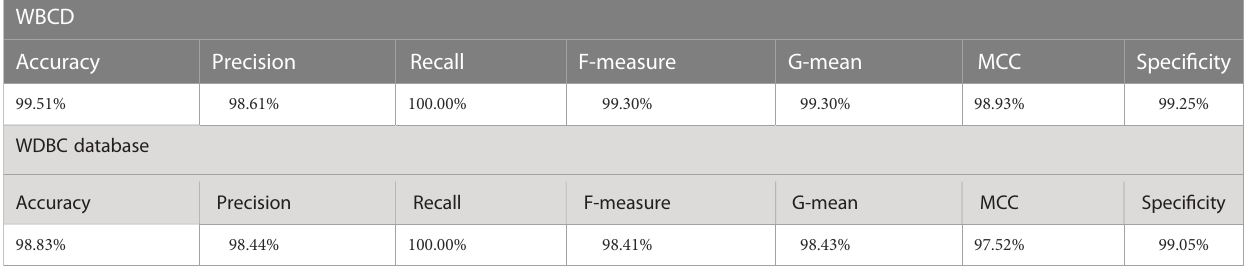
TABLE 8 The highest achieved results of the FLN algorithm using the WBCD and WDBC database.